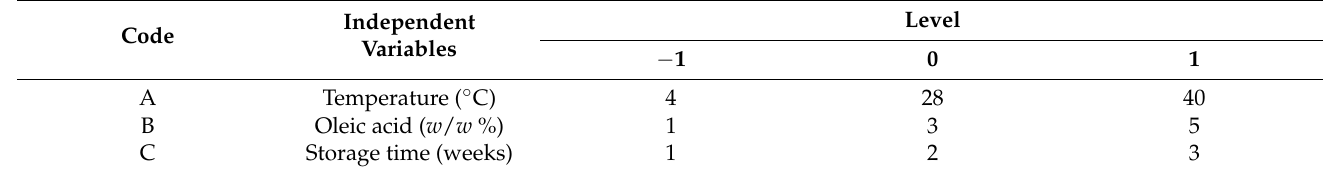
Table 2. Three-level factorial design experiment factors and levels.